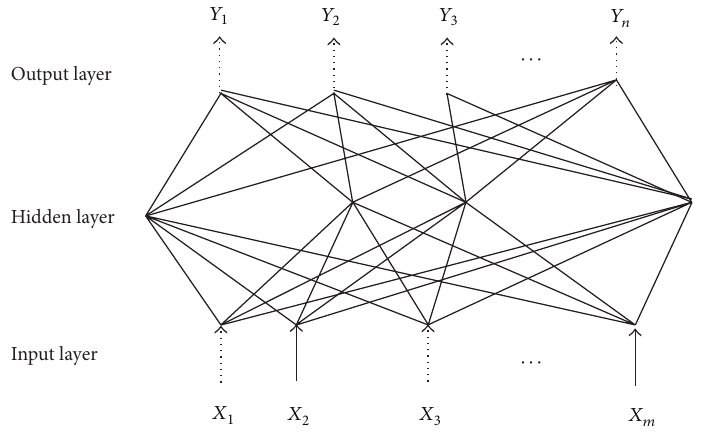
Figure 5: Typical structure of a BP neural network [18].